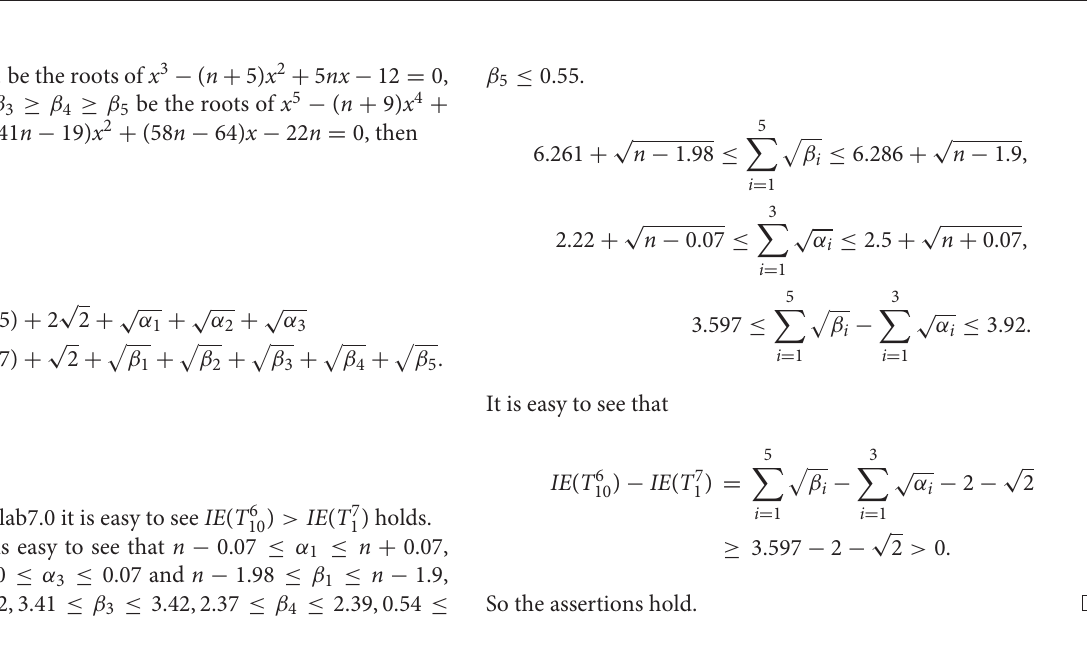
FIGURE 8 | The graphs T 7 i ( i